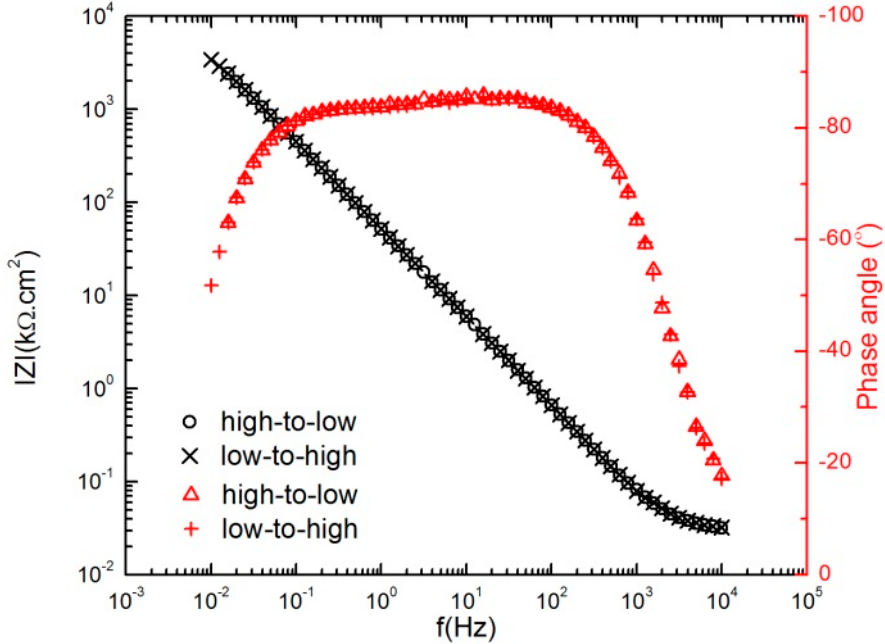
Figure 5. Spectra of the AA2098 – T851 alloy after 24 h of polarization at 300 mV SCE in contact with 1 atm CO 2 (pH = 6.7, 25 °C), including both high-to-low and low-to-high frequency scans during anodic potential stepping.